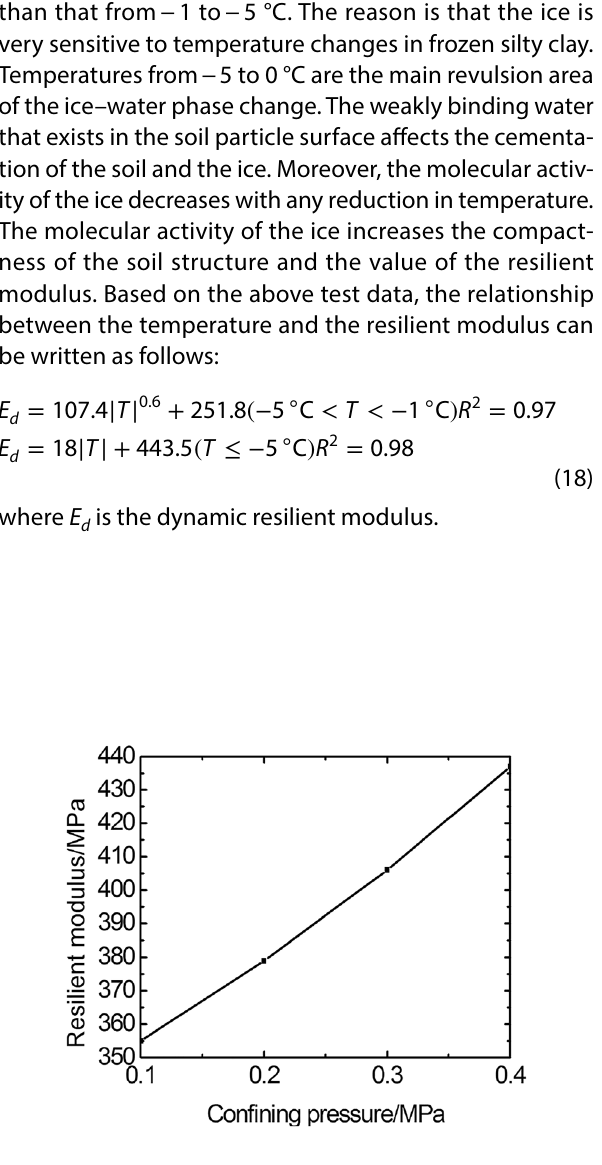
Fig. 8 Influence of the confining pressure on the resilient modulus